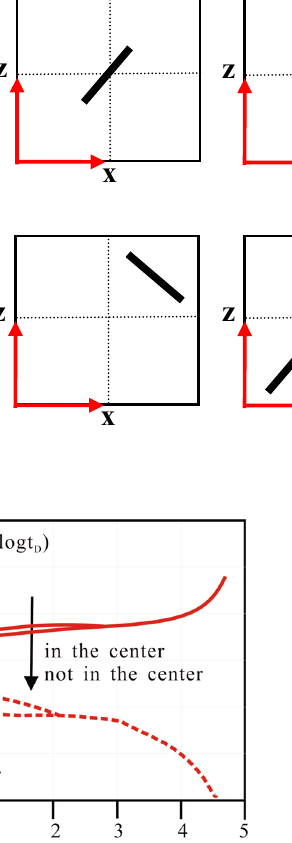
Fig. 6 Schematic diagram of fracture orientation